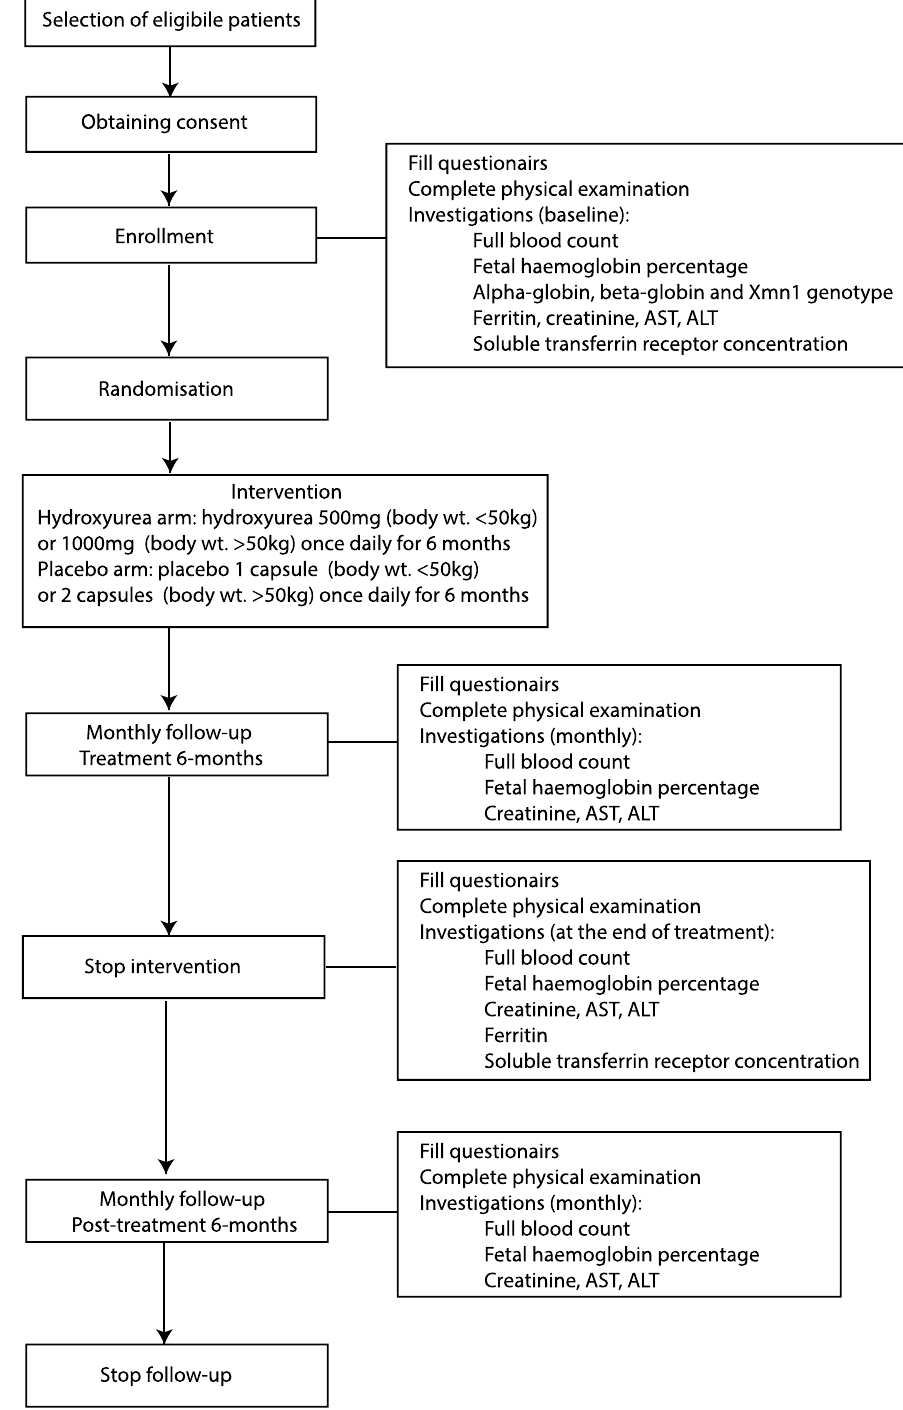
Figure 3. Flow diagram showing study protocol. AST- aspartate aminotransferase, ALT- alanine